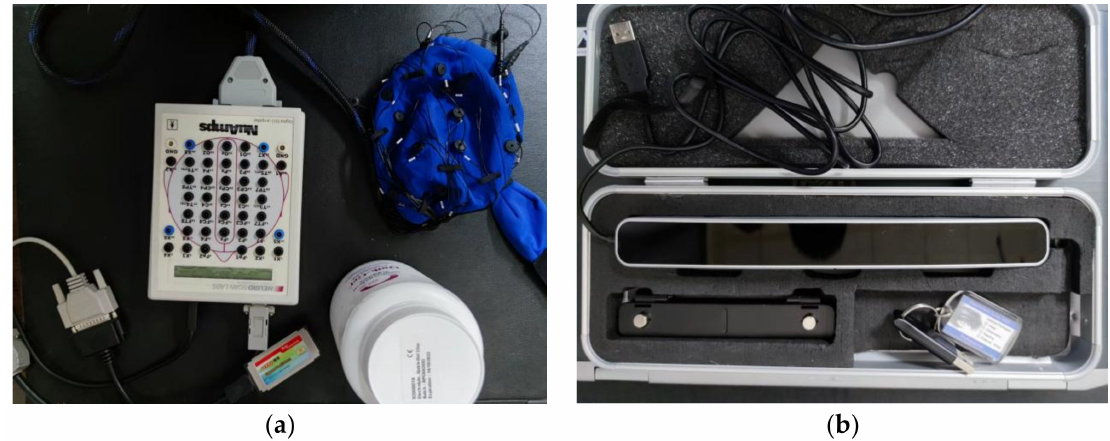
Figure 2. Experimental Test Setup (( a ) Electroencephalograph; ( b ) Eye